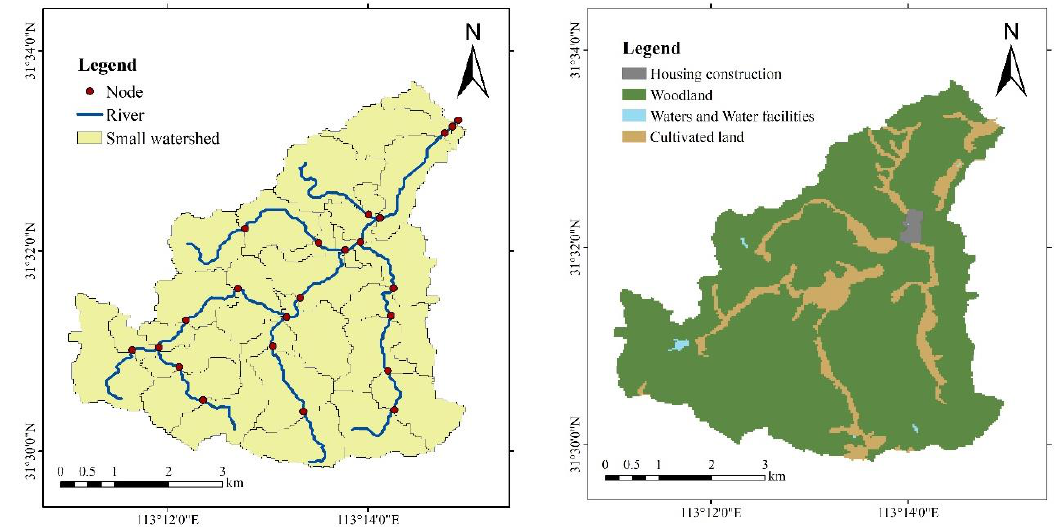
Figure 5. Calculation unit division in Liulin Town and land use attribute data extraction.